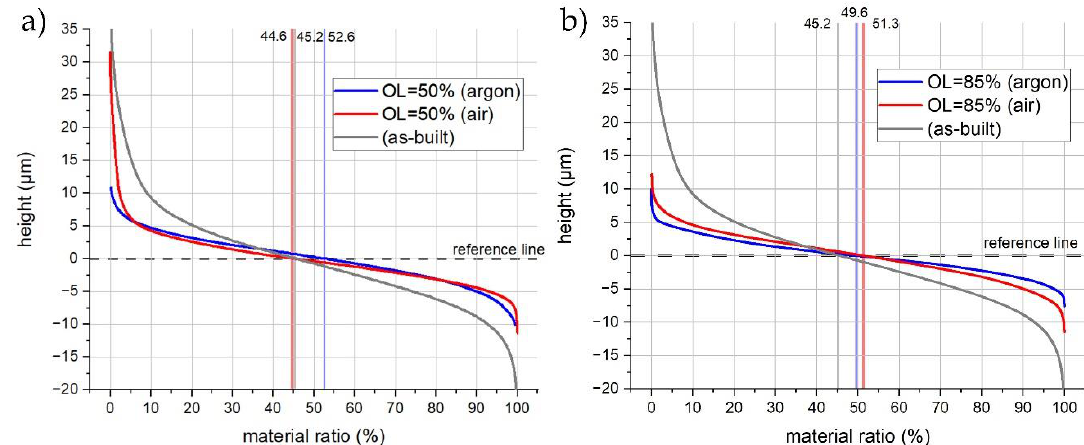
Figure 11. Abbott-Firestone curves for the samples polished in argon and air with OL = 50% ( a ) and OL = 85% ( b ).